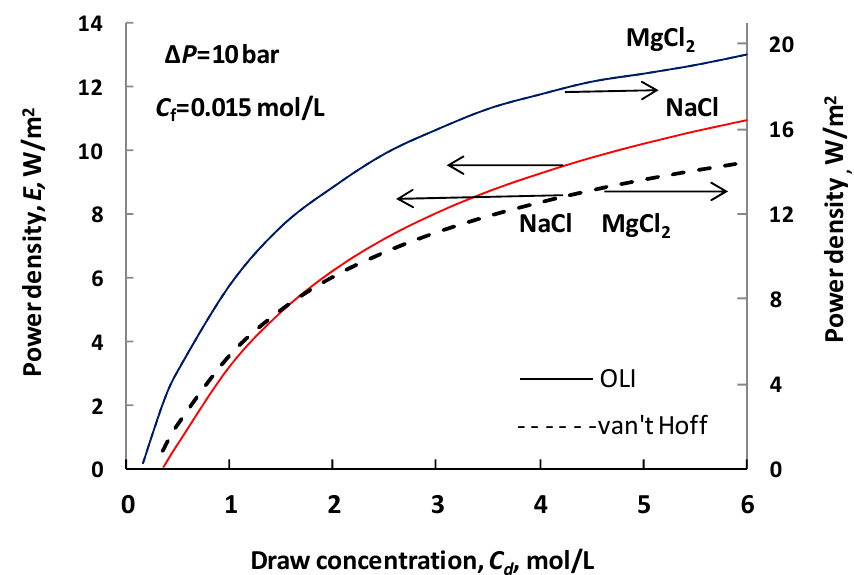
Figure 4. Predicted power density/water flux as a function of the solute concentration for PRO and FO systems comparing the linear approach and the OLI Stream Analyzer’s data [35] for the osmotic pressure. (Other parameters are listed in Table 2).